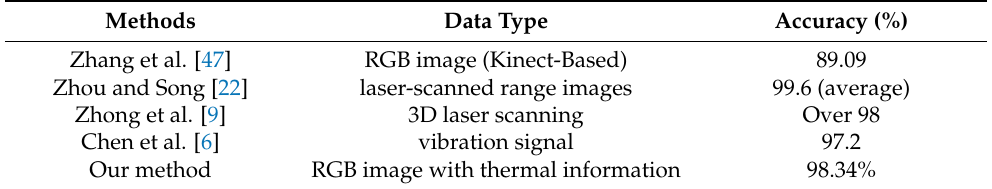
Table 6. Comparison of other mainstream learning-based detection method with proposed method.